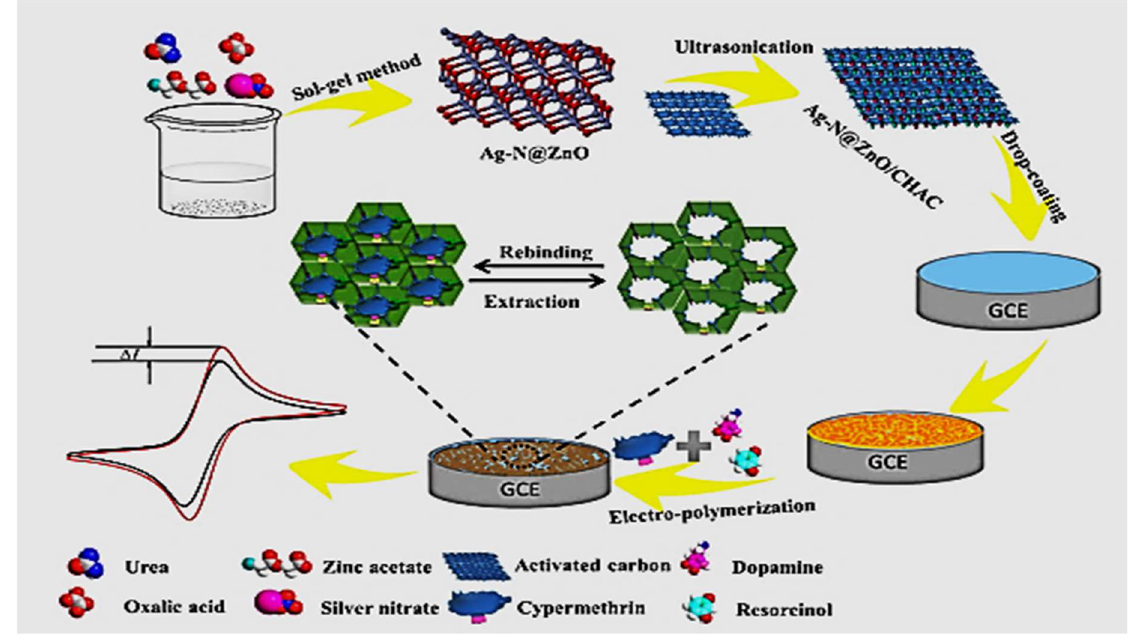
Figure 7. Schematic preparation method of DMMIP-Ag-N@ZnO/CHAC/GCE for the detection of cypermethrin [108]. (Reproduced under permission from Elsevier, doi:10.1016/j.bios.2018.12.002).